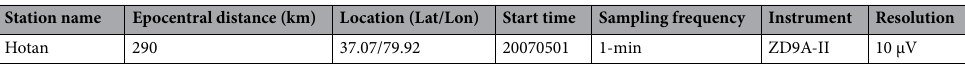
Table 1. Detailed information of the Hotan Geo-electric field